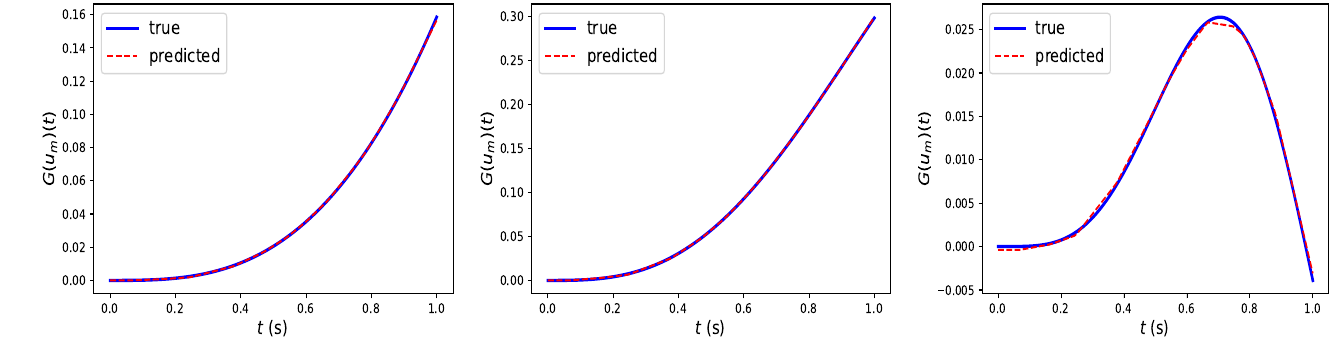
Figure 4. Fed-DeepONet G θ ∗ prediction of three solution trajectories driven by three out-of- distribution inputs: ( left ) u ( t ) = t , ( middle ) u ( t ) = sin ( π t ) , and ( right ) u ( t ) = t sin ( 2 π t ) . The computed L 2 -relative errors are: ( left ) e L Tables 1 and 2 depict the mean and standard deviation of the L 2 -relative errors e L